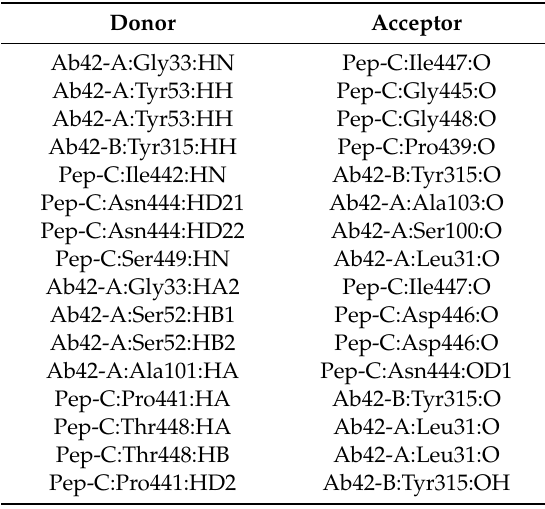
Figure 2. The interaction of Ab 42 with pCFH. ( A ) atomic surface contact of pCFH with Ab42 CDR; ( B ) two dimensional diagram of the interaction between pCFH and Ab42, with pCFH displayed by ball and stick and the key residues in CDR displayed by disc presentation. Table 1. The hydrogen bonds formed in the docking complex.